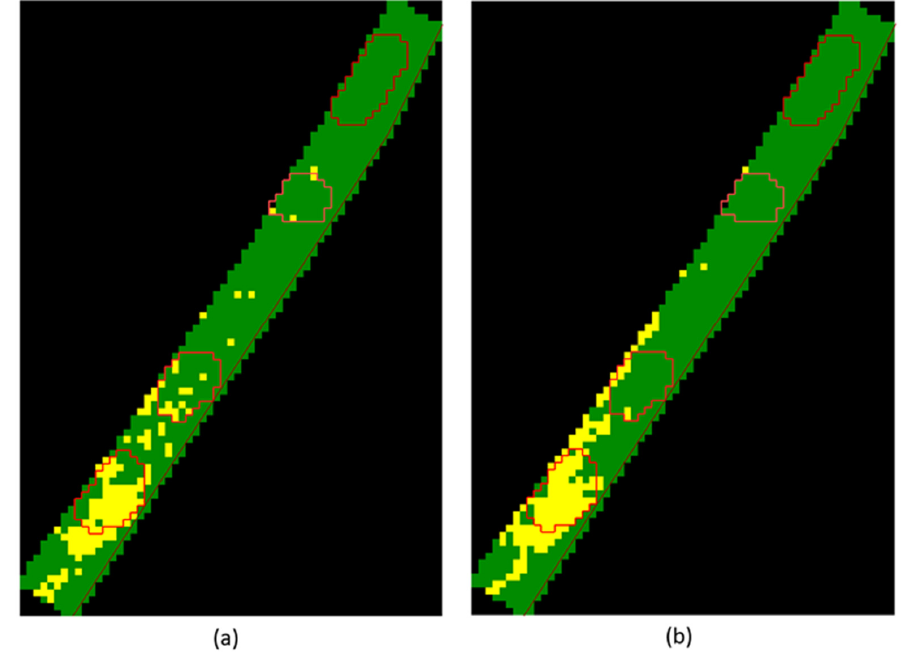
Figure 7. Minimum distance classification, using: ( a ) Euclidean distance; and ( b ) Mahalanobis distance.